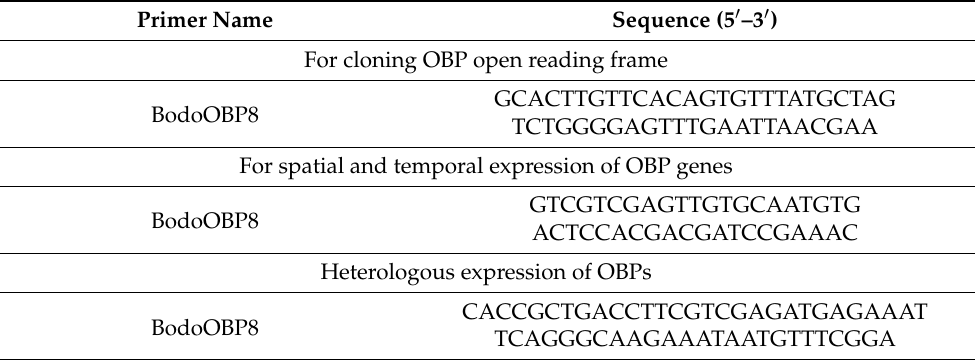
Table 1. Primers used in cloning and expression of OBP genes in B.odoriphaga .